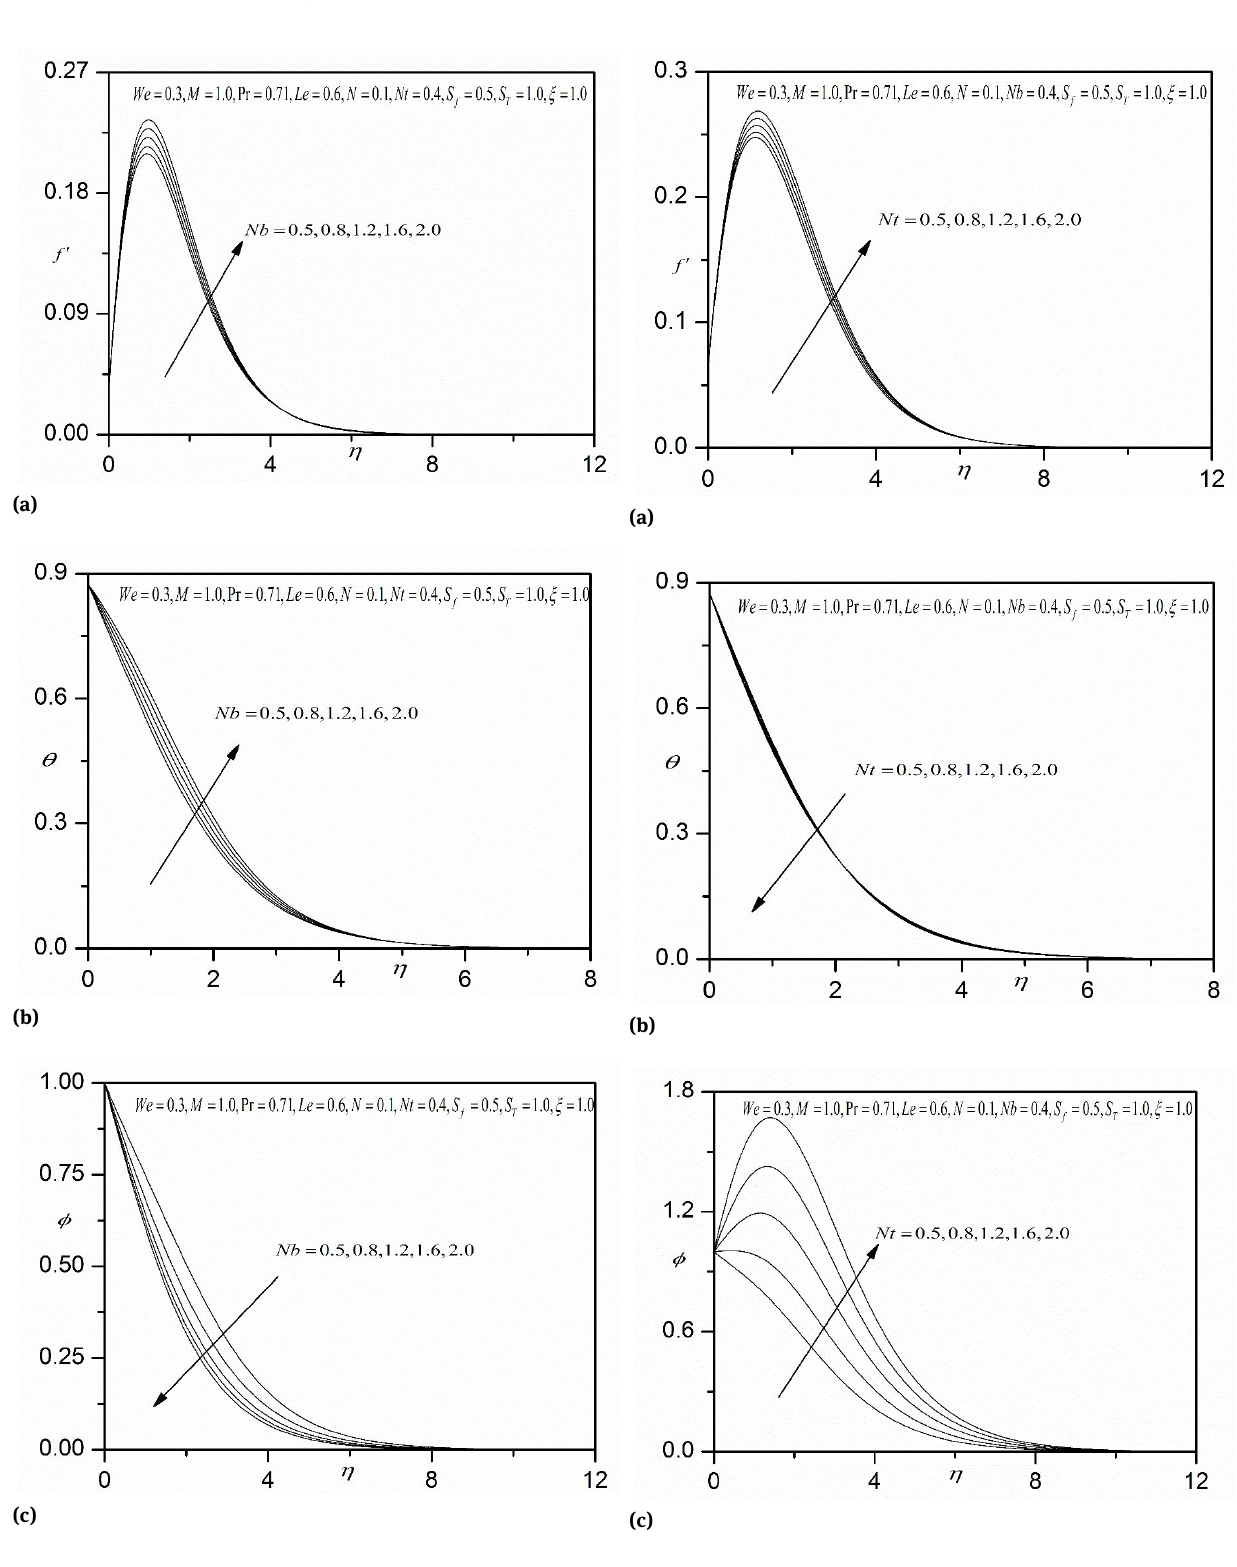
Fig. 10: (a) Effect of Nb on velocity profile; (b) Effect of Nb on temper- ature profile; (c) Effect of Nb on concentration profiles.